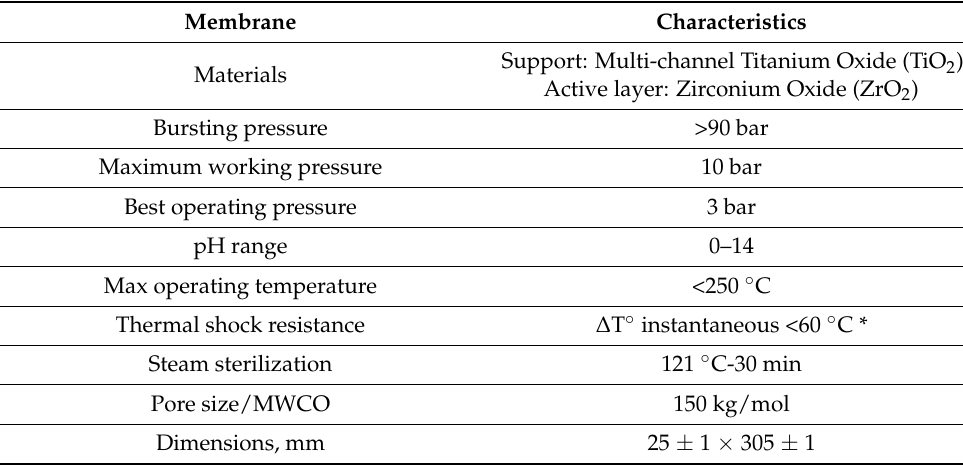
Table 1. Ultrafiltration ceramic membrane characteristics.